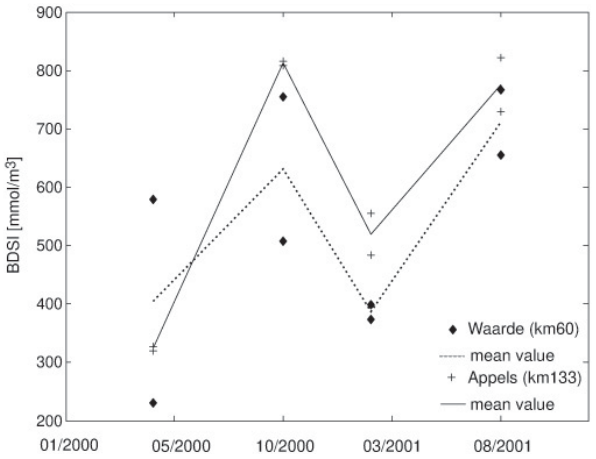
Fig. 7. Observed depth-averaged dissolved silica concentrations in two cores (single values are indicated by diamonds (Waarde), crosses (Appels)) at two sites in the Scheldt estuary (February 2000–August 2001, Hyacinthe, unpublished